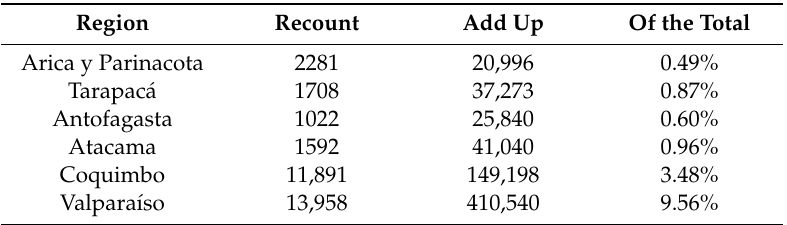
Table 3. Spatial distribution of permits in the territory by political-administrative region. Source: Compiled by the authors based on DGA data. Region